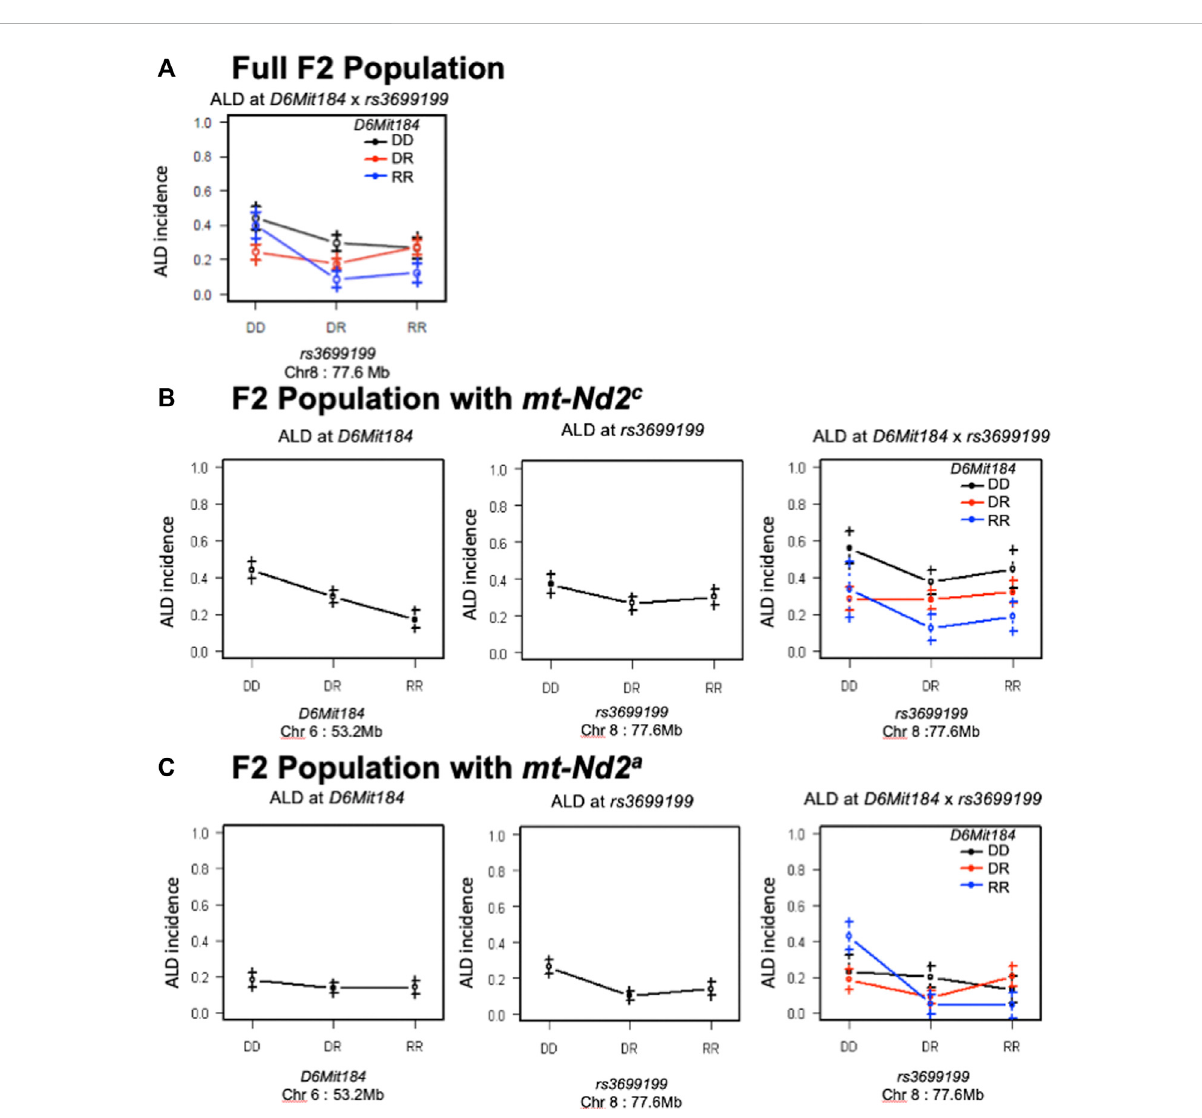
FIGURE 7 The interaction between Chr 8 and 6 were analyzed in 2 subgroups according to mt-genotype. Panel (A) shows the interactions of Chr 8 and Chr 6 in the full population of F2 mice. Panel (B) , interaction in the subgroup of mice with NOD derived mt-Nd2 c type. In this subgroup, coexistence of homozygous DD type on both chromosomes denotes the highest susceptibility to ALD; panel (C) , interaction in the subgroup of mice with mt- Nd2 a type. In this group, homozygous DD on Chr 8 and RR on Chr 6 confer the highest susceptibility to